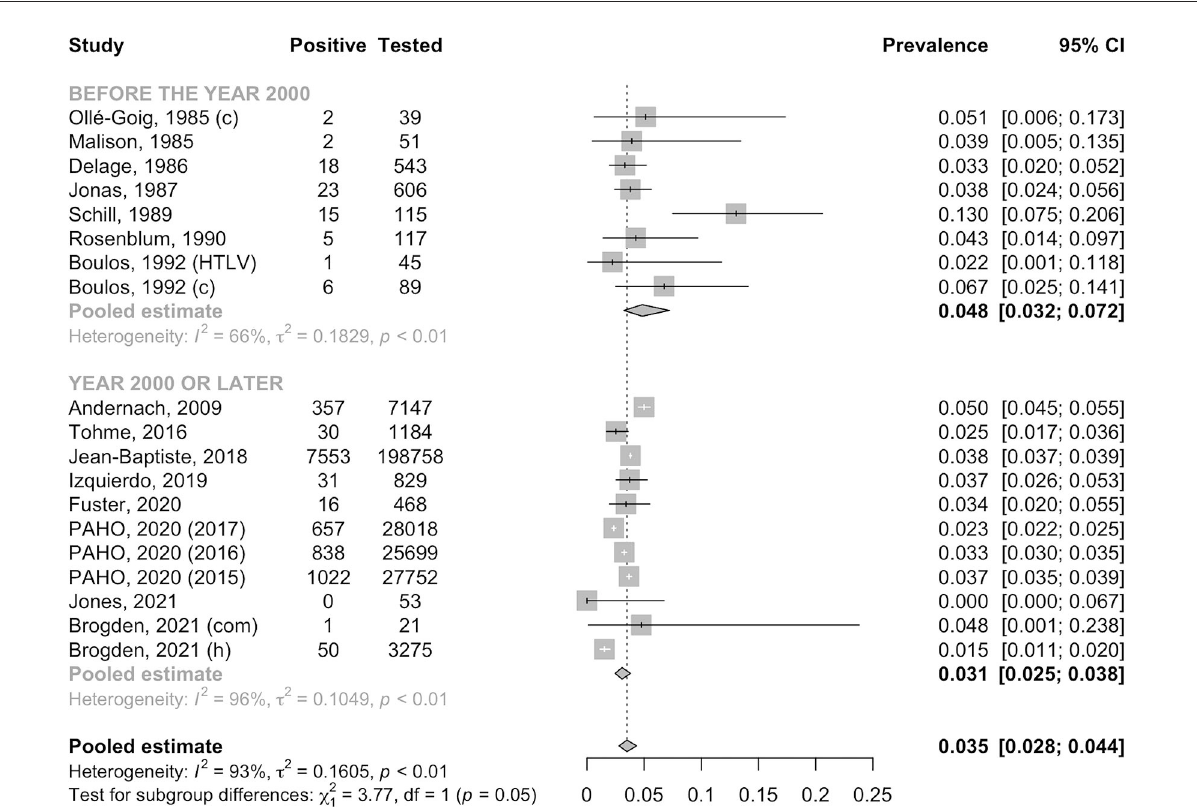
FIGURE3 Prevalence of HBsAg in the general adult population by year. c, control group; com, community recruitment; h, hospital recruitment; HTLV, human T-cell lymphotropic virus positive group; PAHO, Pan American Health Organization.